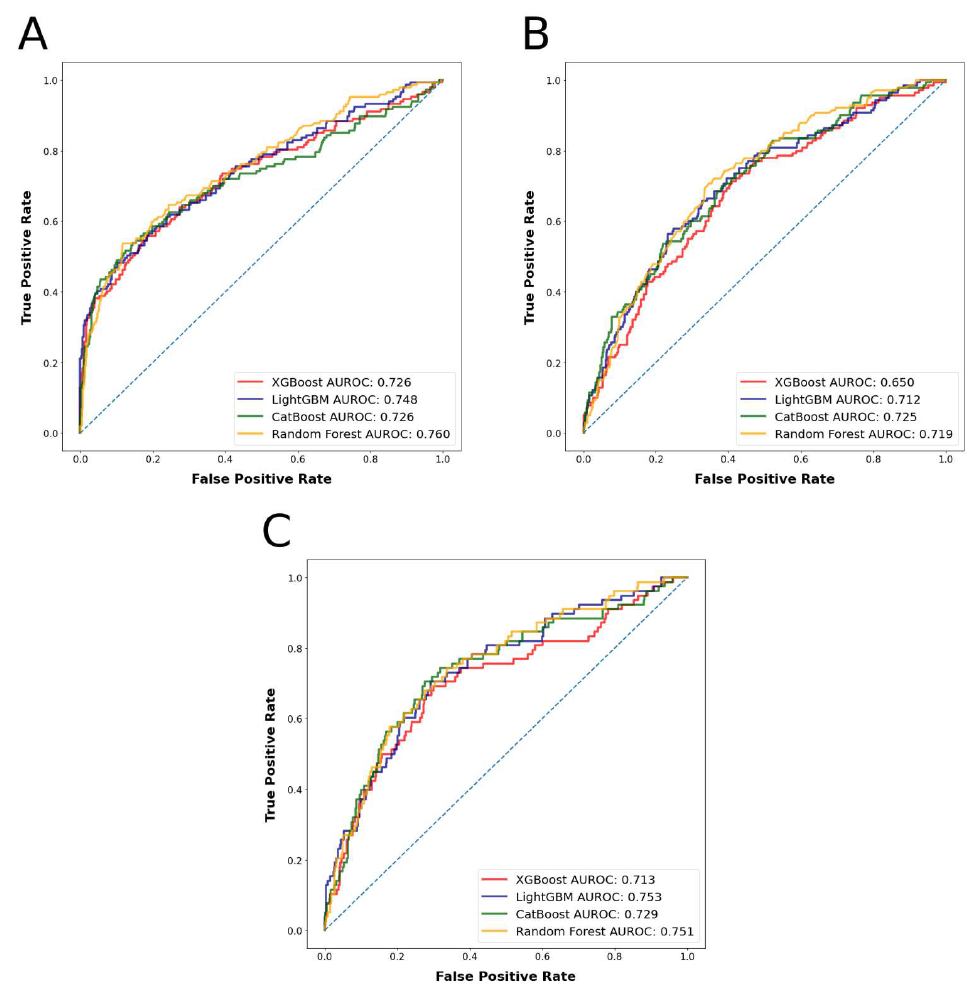
Figure 3. ( A ): Algorithms’ receiver operator curves for the outcome prolonged length of stay. ( B ): Algorithms’ receiver operator curves for the outcome nonhome discharges. ( C ): Algorithms’ receiver operator curves for the outcome major complications.